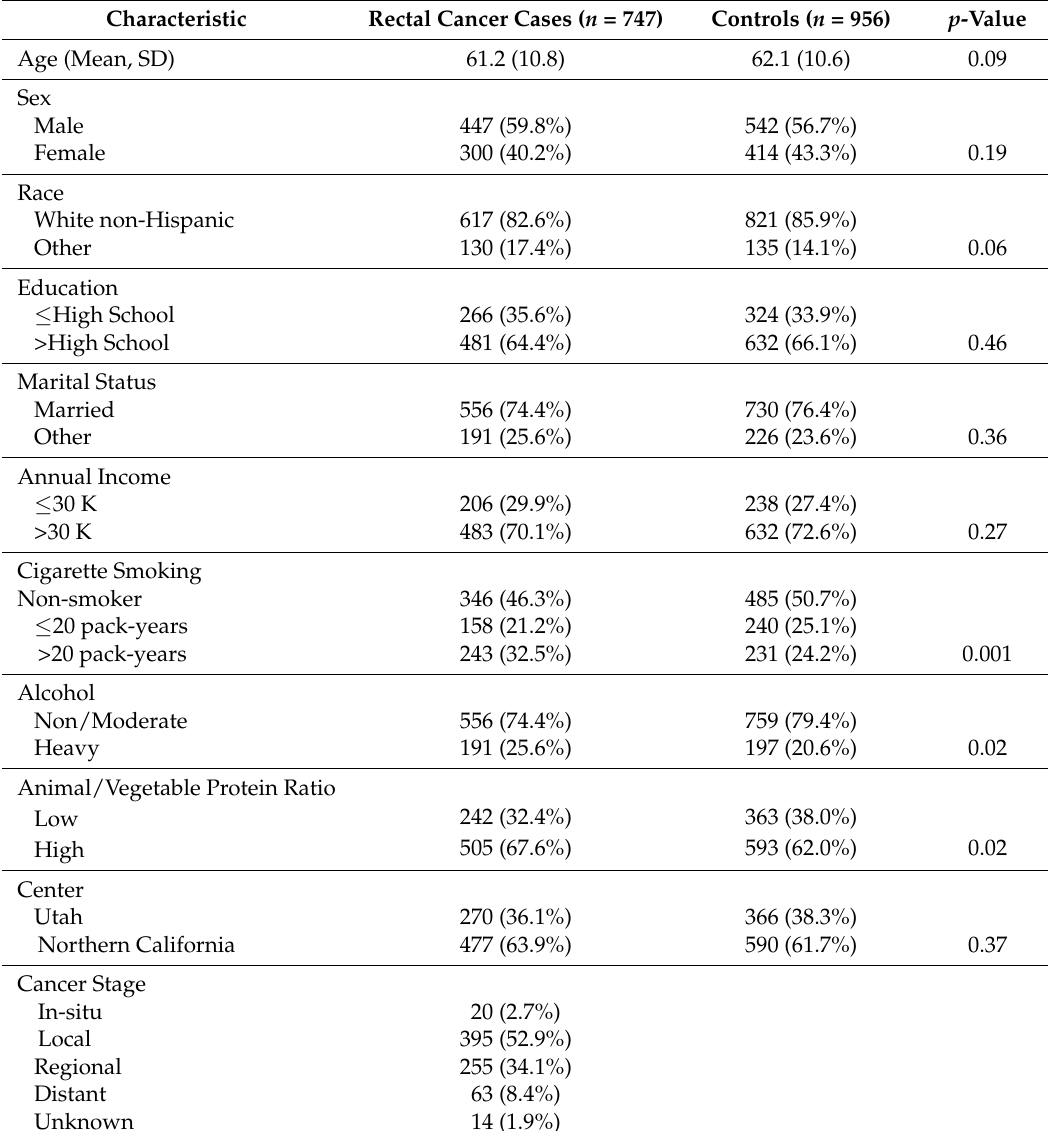
Table 2. Demographic characteristics of study